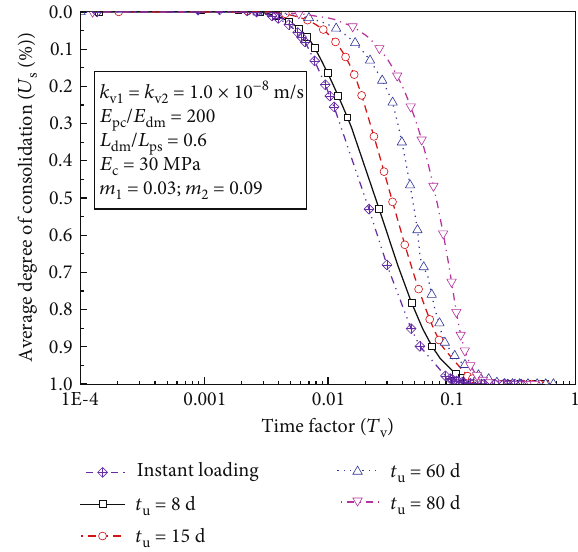
Figure 11: E ff ect of E